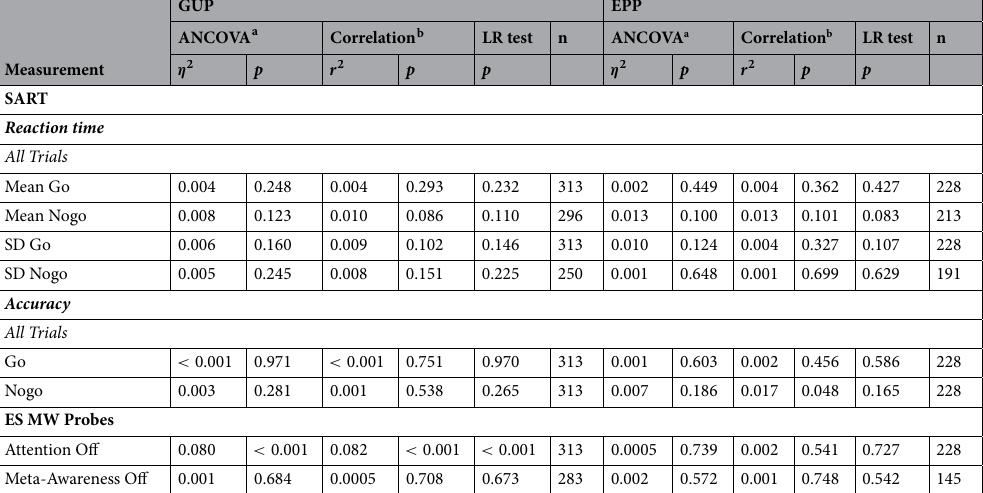
Table 5. MAAS total score as covariate compared to correlation coefficients and model comparison ANOVA versus ANCOVA. a Effect sizes for the MAAS total score covariate in ANCOVAs. b Pearson product-moment correlations between MAAS total score and the SART and ES measures. LR test = Likelihood-ratio test between ANOVA and ANCOVA models. η 2 = Eta-squared effect size as proportion of variance explained by the predictor. r 2 = r-squared coefficient of determination based on the correlation coefficients, as proportion of shared variance among the two correlated